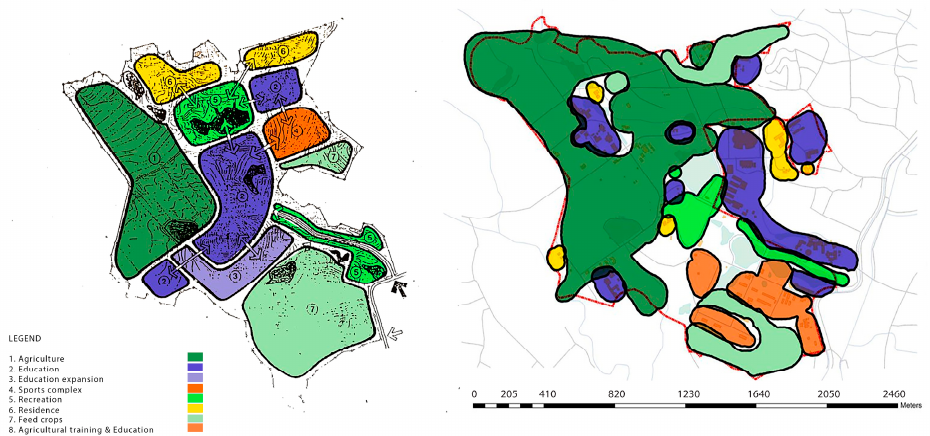
Figure 4. The comparison between the 1987 proposed masterplan and the surveyed land